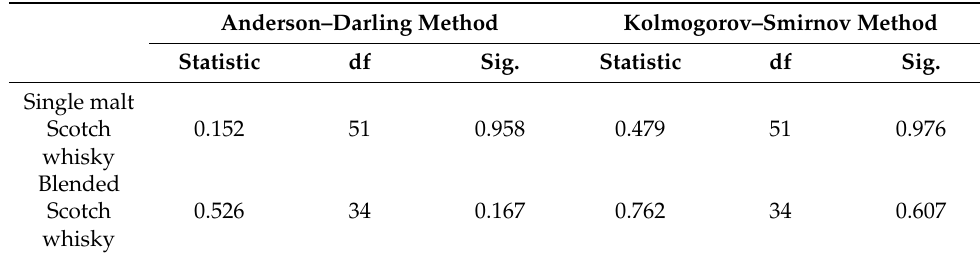
Table 1. Normality test results of log-transformed δ 13 C-ethanol data of authentic Scotch whiskies. Anderson–Darling